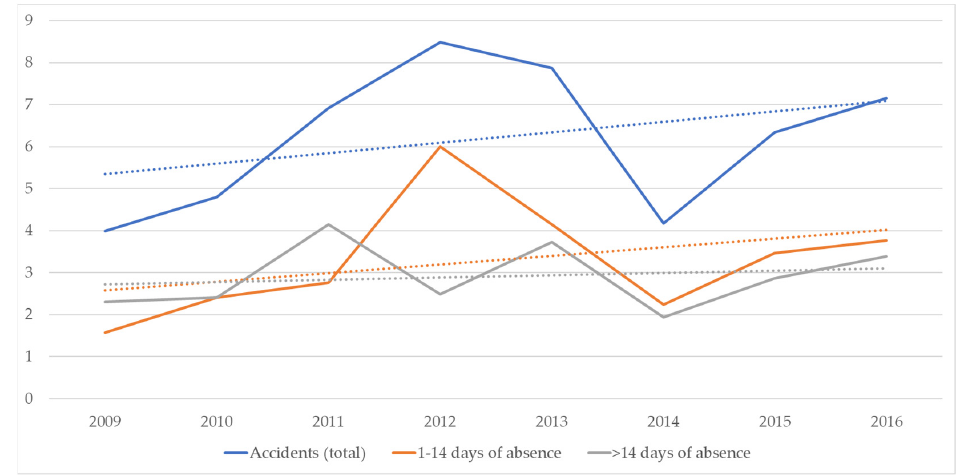
Figure 12. Incidence rates in plastering. Based on data from [17 – 24 , 27] .